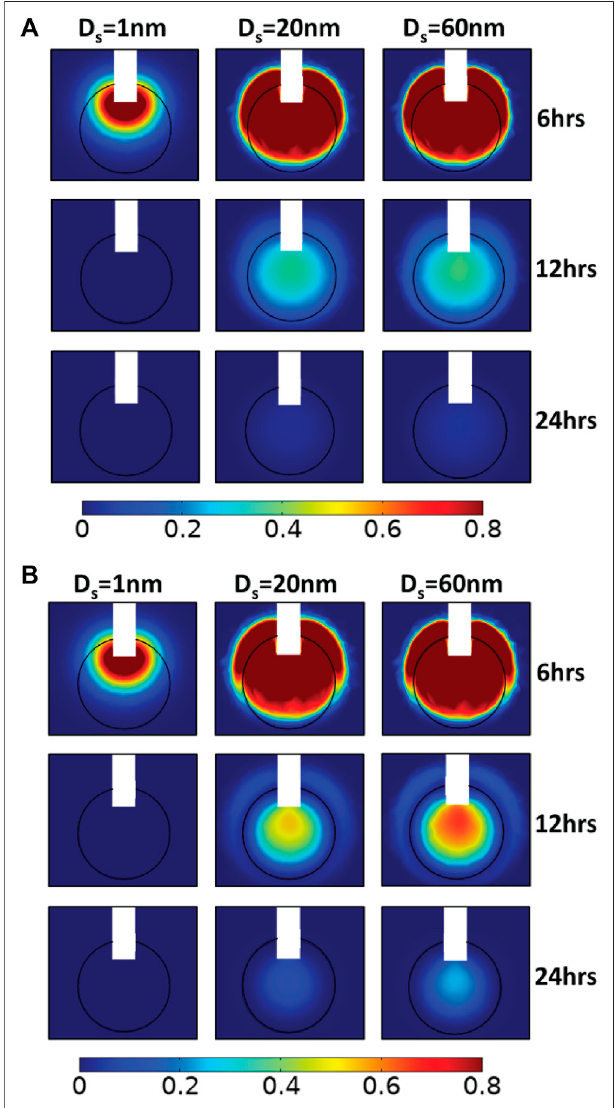
FIGURE 5 | Simulated drug concentration with different vessel wall pore diameters. A sagittal view in the center of tumor tissue showing the spatial distribution of drug concentration for 2 × 10 − 13 m 2 /(Pa s) hydraulic conductivity of the tumor interstitial space, for different diameters of the therapeutic agent, D s : 1, 20, and 60 nm in three snapshot: 6, 12, and 24 h, and for different pore diameters of tumor vessel walls, D o : (A) 50 nm and (B) 150 nm. Drug concentration is normalized by division with the reference value entering the